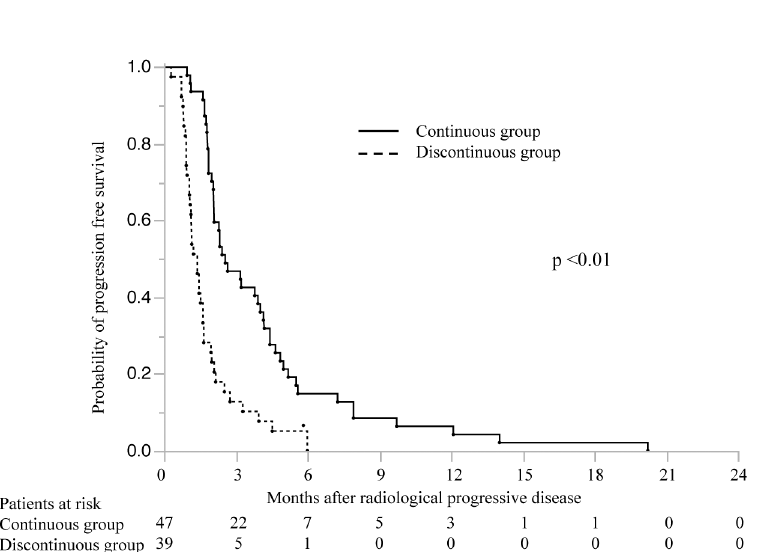
Fig 1. Progression-free survival in patients in the continuous (n = 47) and discontinuous (n = 39) sorafenib groups after radiologic confirmation of progressive disease. The numbers below the x-axis indicate the number of patients at